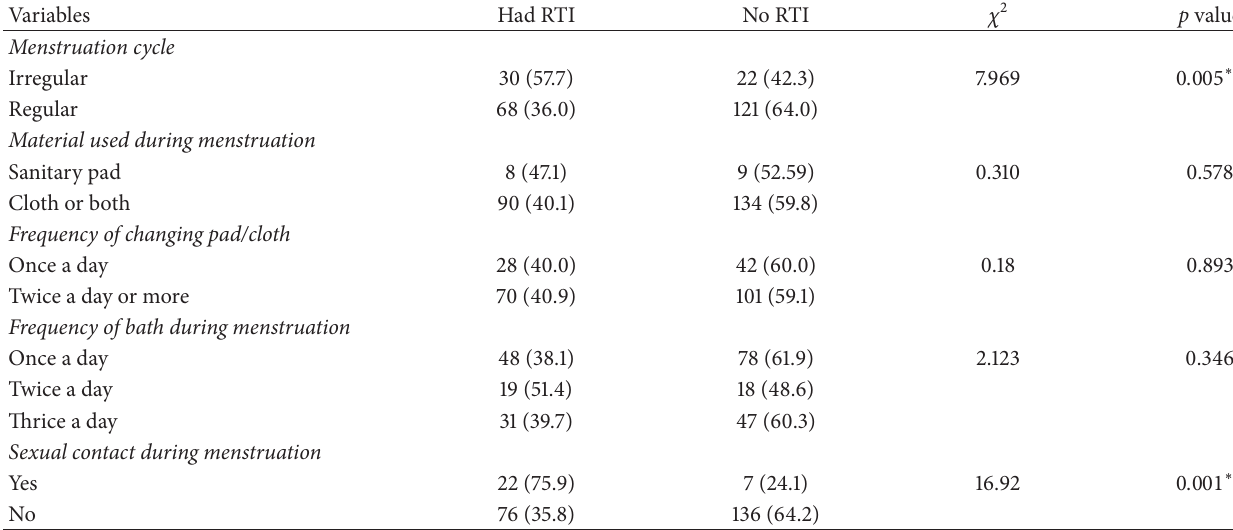
Figure in parenthesis indicates percentage, ∗∗ statistically highly significant at 𝑝 < 0.01 .